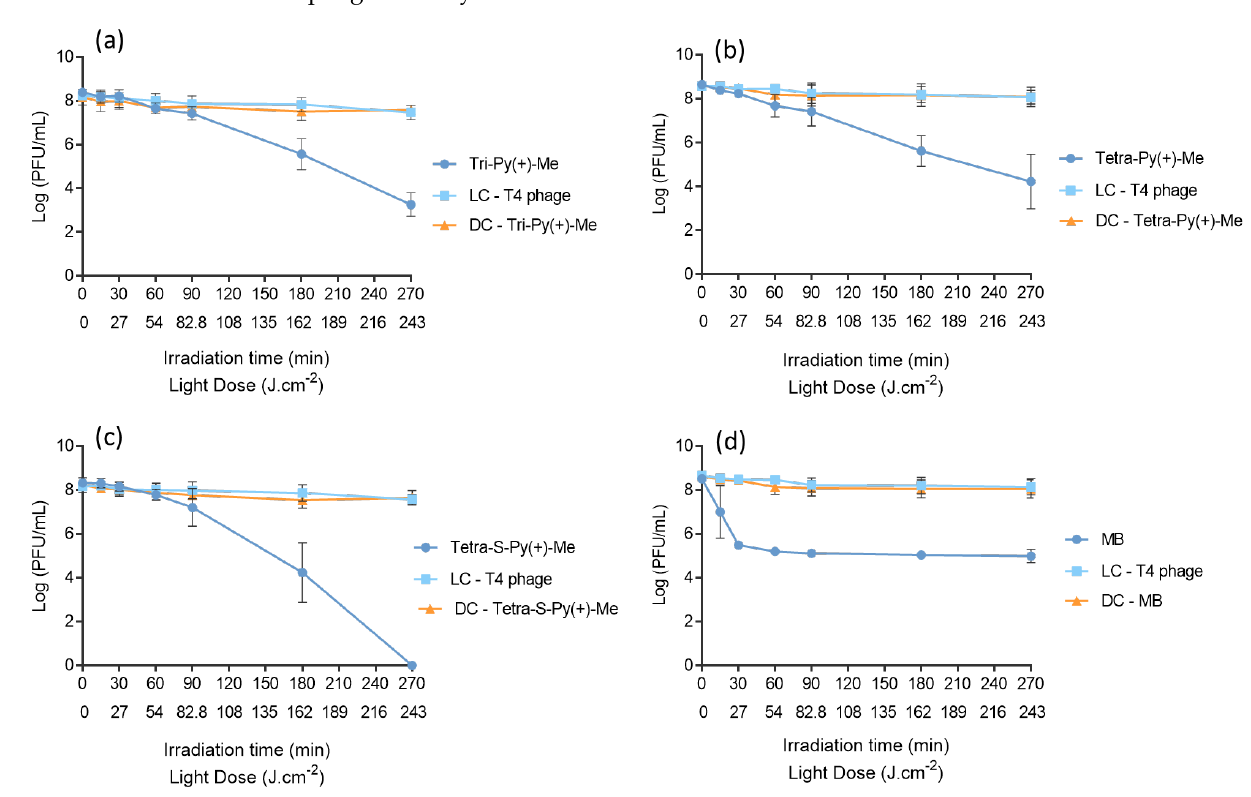
Figure 5. T4-like phage photoinactivation in plasma in the presence of ( a ) Tri-Py(+)-Me, ( b ) Tetra- Py(+)-Me, ( c ) Tetra-S-Py(+)-Me, and ( d ) MB at 10 µM and under white light irradiation at an irradiance of 150 mW·cm − 2 . All values represent the average of three independent assays in duplicate. Error bars indicate the standard deviation and in some cases are collapsed with the symbols. Lines were used to connect the data points. LC — Light control; DC — Dark control.